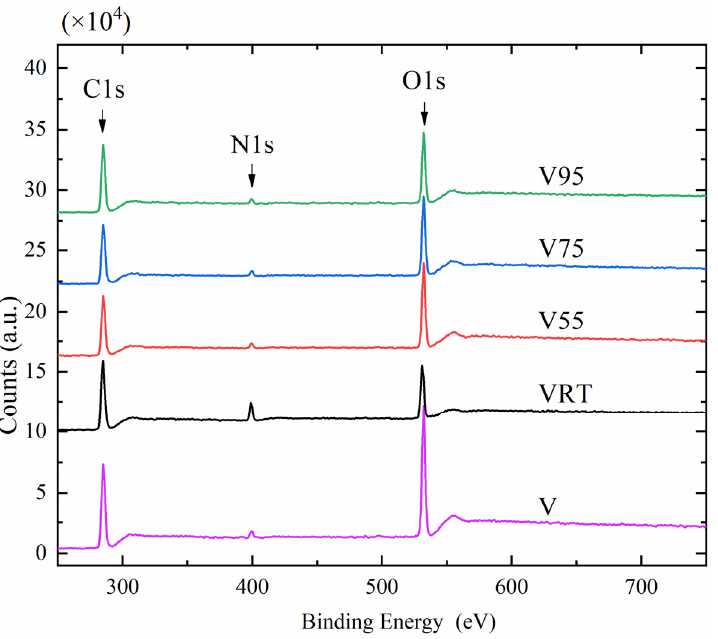
Figure 6. XPS spectra of nanofiber samples (Peaks of C, O, N are marked out.)